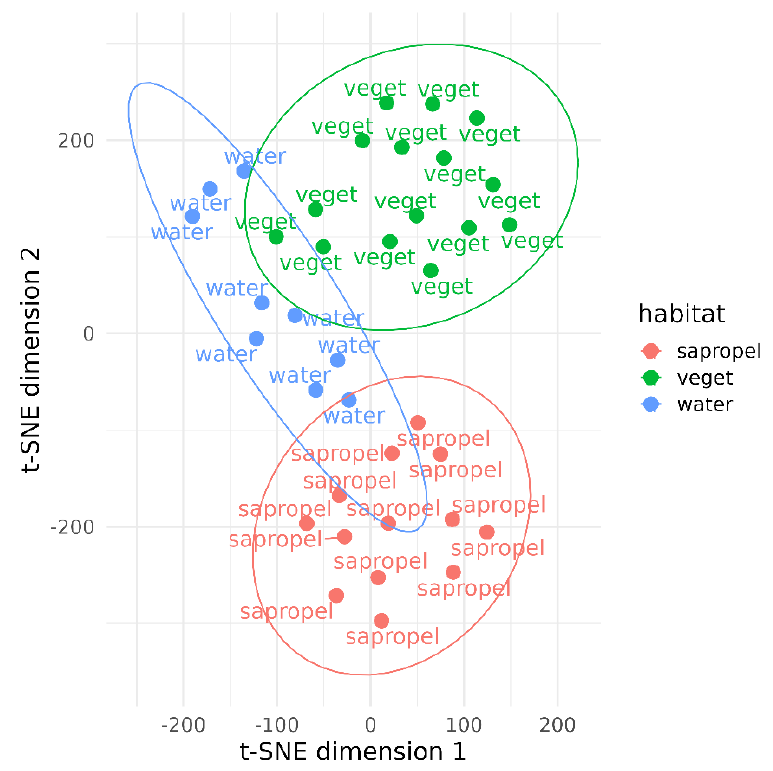
Figure 9. The t – SNE of habitats based on the abundance of indicator species. Figure 9. The t–SNE of habitats based on the abundance of indicator